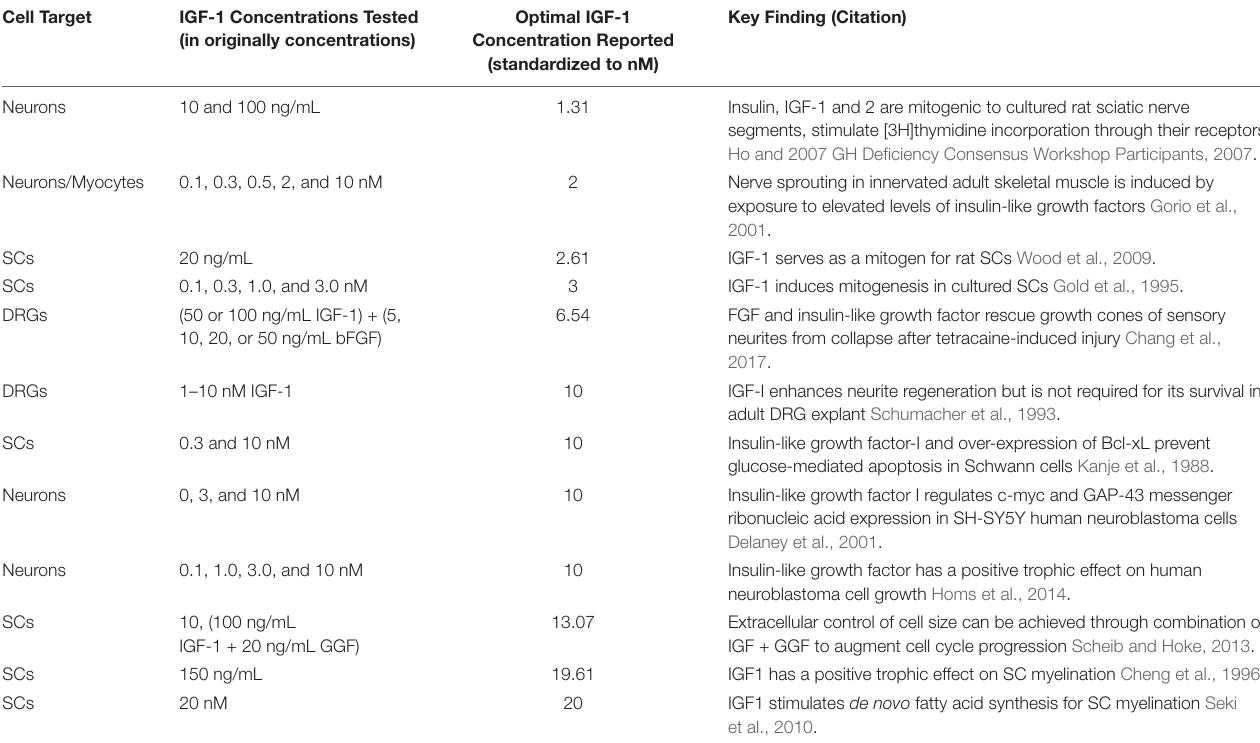
TABLE 1 | In vitro studies of IGF-1 on neurons, SCs, and DRG cells (IGF-1, insulin-like growth factor 1; SC, schwann cells; DRG, dorsal root ganglion, bFGF, basic fibroblast growth factor; Bcl-xL, B-cell lymphoma-extra large; C-myc, cellular-myc; GAP-43, growth-associated protein 43; GGF, glial growth factor). Cell Target IGF-1 Concentrations Tested (in originally